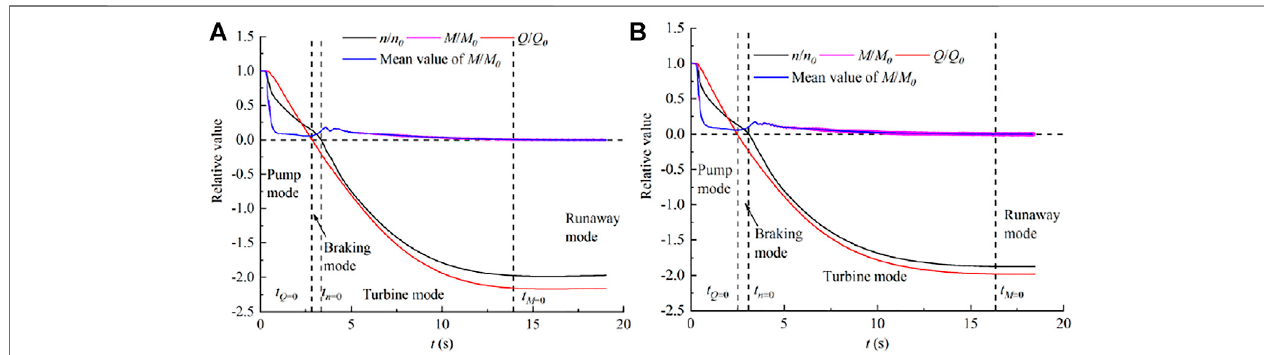
FIGURE 6 | Relative values of dynamic parameter variations with time. (A) Case 1. (B) Case 2.